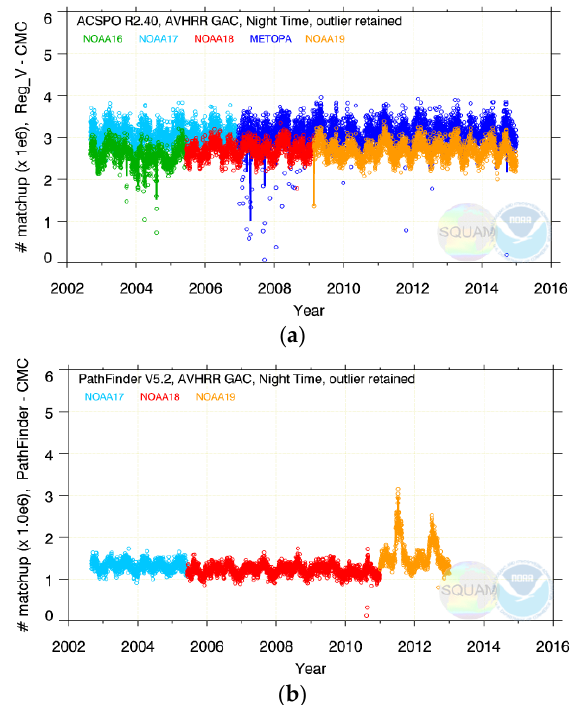
Figure 6. Daily number of nighttime SSTs with QL = 5 in: ( a ) RAN1; ( b ) PFV5.2.